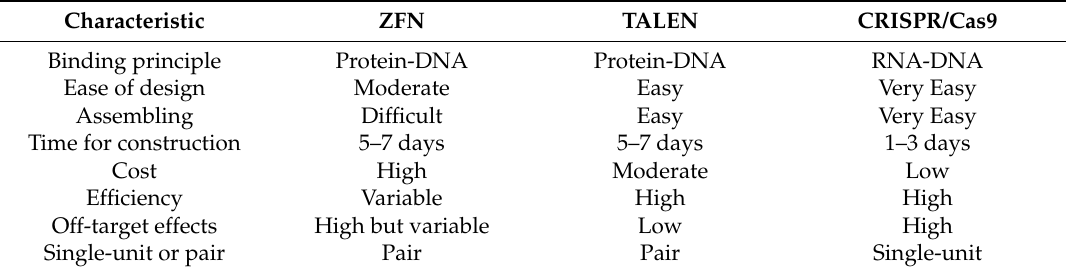
Table 2. Characteristics of different gene editing tools (Adapted from Chen and Gao